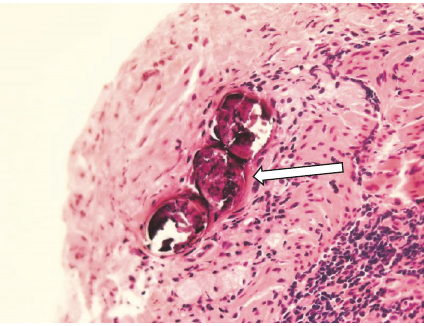
Figure 12: 400x histopathology showing old S. japonicum eggs